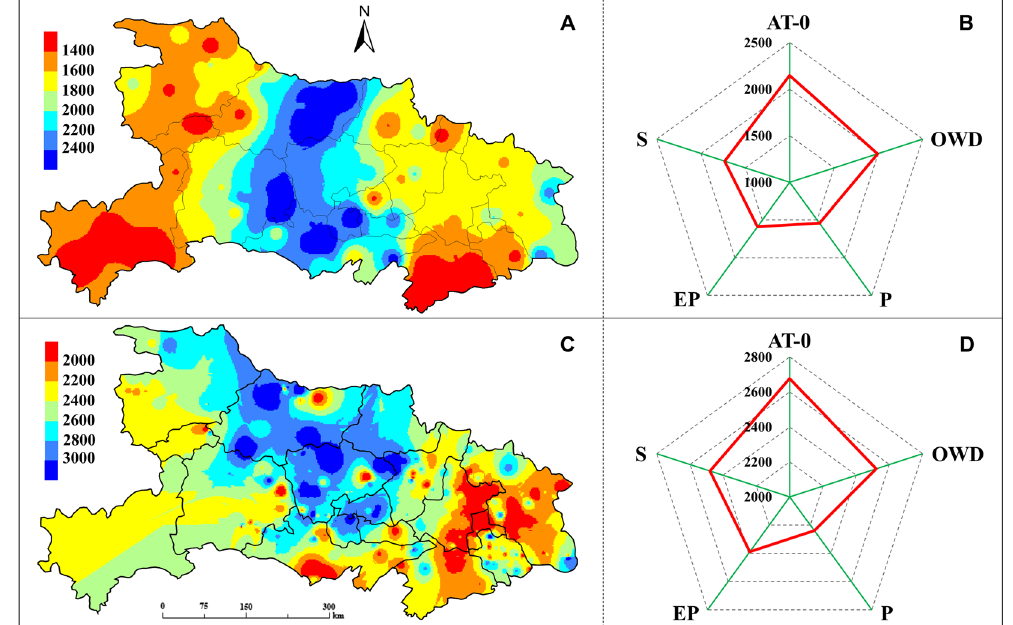
Figure 4. Spatial distribution of the actual farmers’ yield ( A ) and the experimental yield ( C ), and the values for different yield-limiting agroclimatic factors ( B and D ). AT-0 mean ≥ 0 °C accumulated temperature, OWD mean overwintering days, P mean precipitation, EP mean precipitation at an earlier stage, S mean sunshine hours. Figure was created by ArcGIS Desktop (Version 9.3, URL: http://www.esri.com)